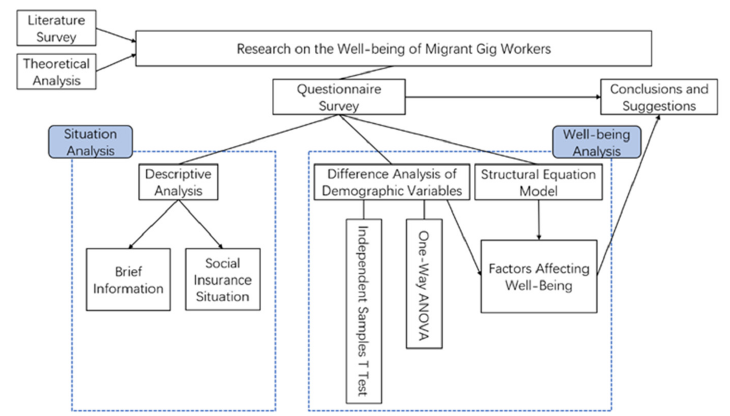
Figure 2. Research